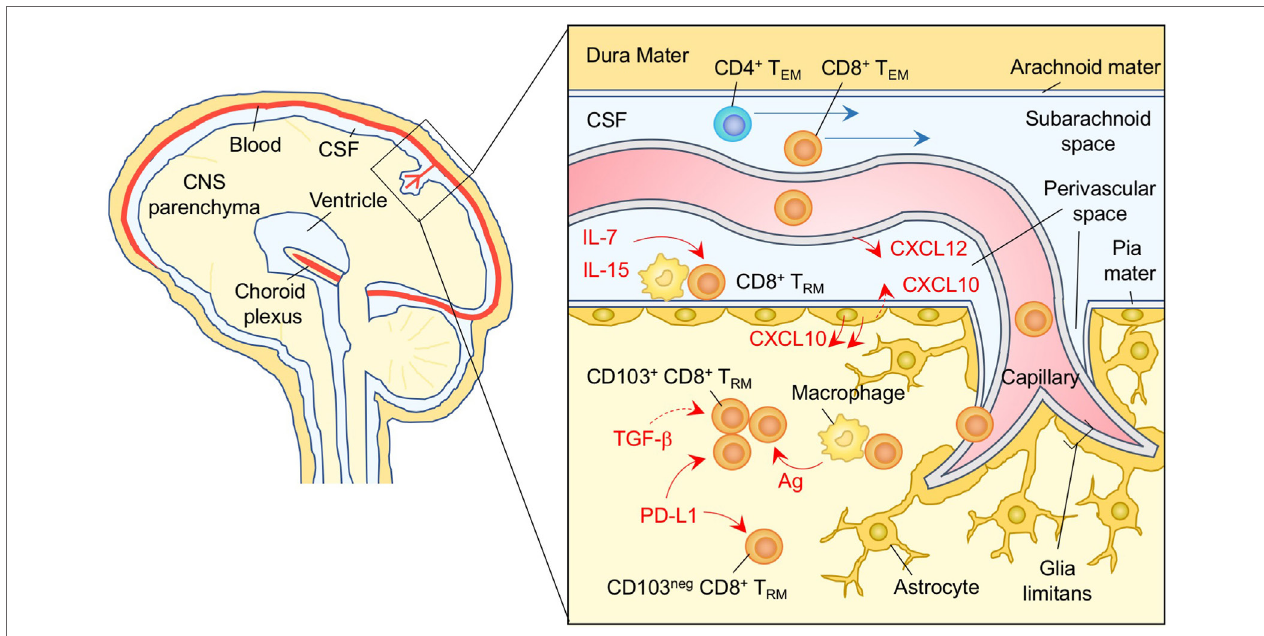
FiGURe 6 | T RM niches in the in the brain. CXCL12 is constitutively expressed on the basolateral surface of endothelial cells, and recruits CXCR4 + CD8 + T cells to the perivascular spaces. Subsequent migration of cells in the brain parenchyma is promoted by chemokines such as ligands for CXCR3 and CCR5 secreted by astrocytes. CD8 + T RM cells are established in the parenchyma and perivascular spaces of the brain. Parenchymal CD8 + T RM cells are divided by the expression of CD103. Although upregulation of CD103 depends largely on cognate antigen, TGF- β may be involved in this process. PD-1 is highly expressed on both CD103 + and CD103 − CD8 + T RM cells in the brain parenchyma independent of either antigen or inflammatory signals. Signaling through PD-1 promotes the establishment of CD8 + T RM cells in the brain parenchyma. IL-7 and IL-15 are available in the perivascular spaces, and sustain the homeostatic proliferation of CD8 + T RM cells in this compartment. T EM cells are passing through the cerebrospinal fluid (CSF). Orange and blue cells indicate CD8 + and CD4 + T RM cells, respectively, unless otherwise stated. Red lines indicate the representative niche factors that influence the maintenance of T RM cells. Blue lines indicate the migratory route. Dashed lines indicate potential impact of niche factors. Abbreviations: Ag, antigen; neg, negative; T RM , tissue-resident memory T cells; T EM , effector memory T